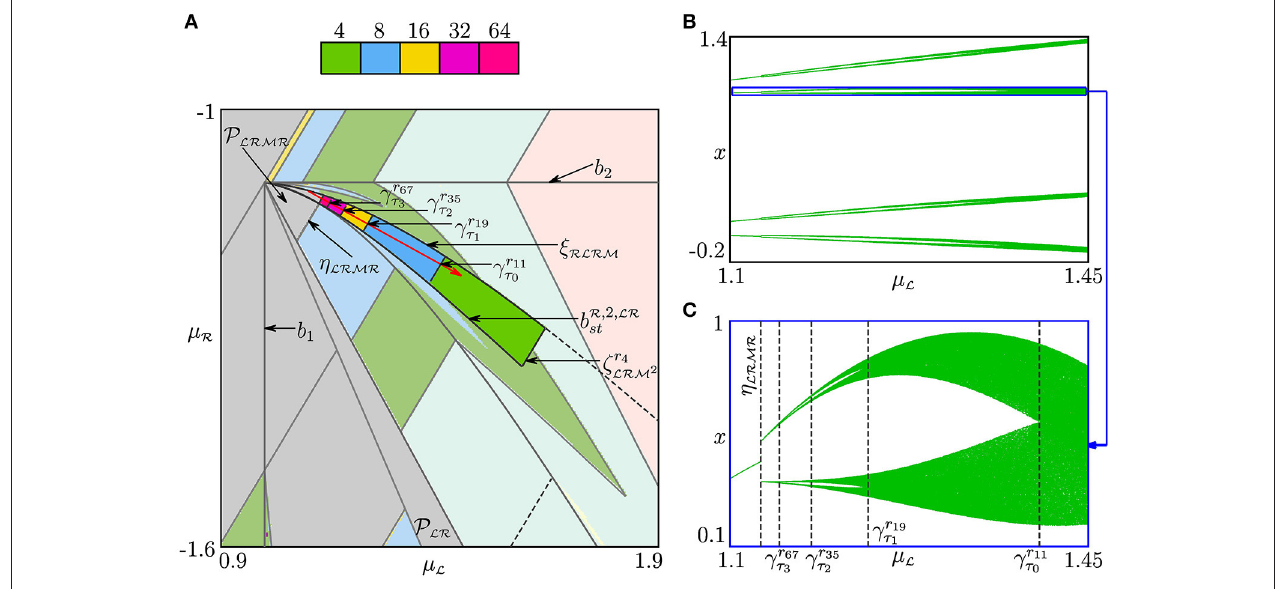
FIGURE 14 | (A) Bifurcation structure of the region D R ,2, LR st . Bifurcation diagram (B) along the arrow shown red in (A) and its enlargement (C)